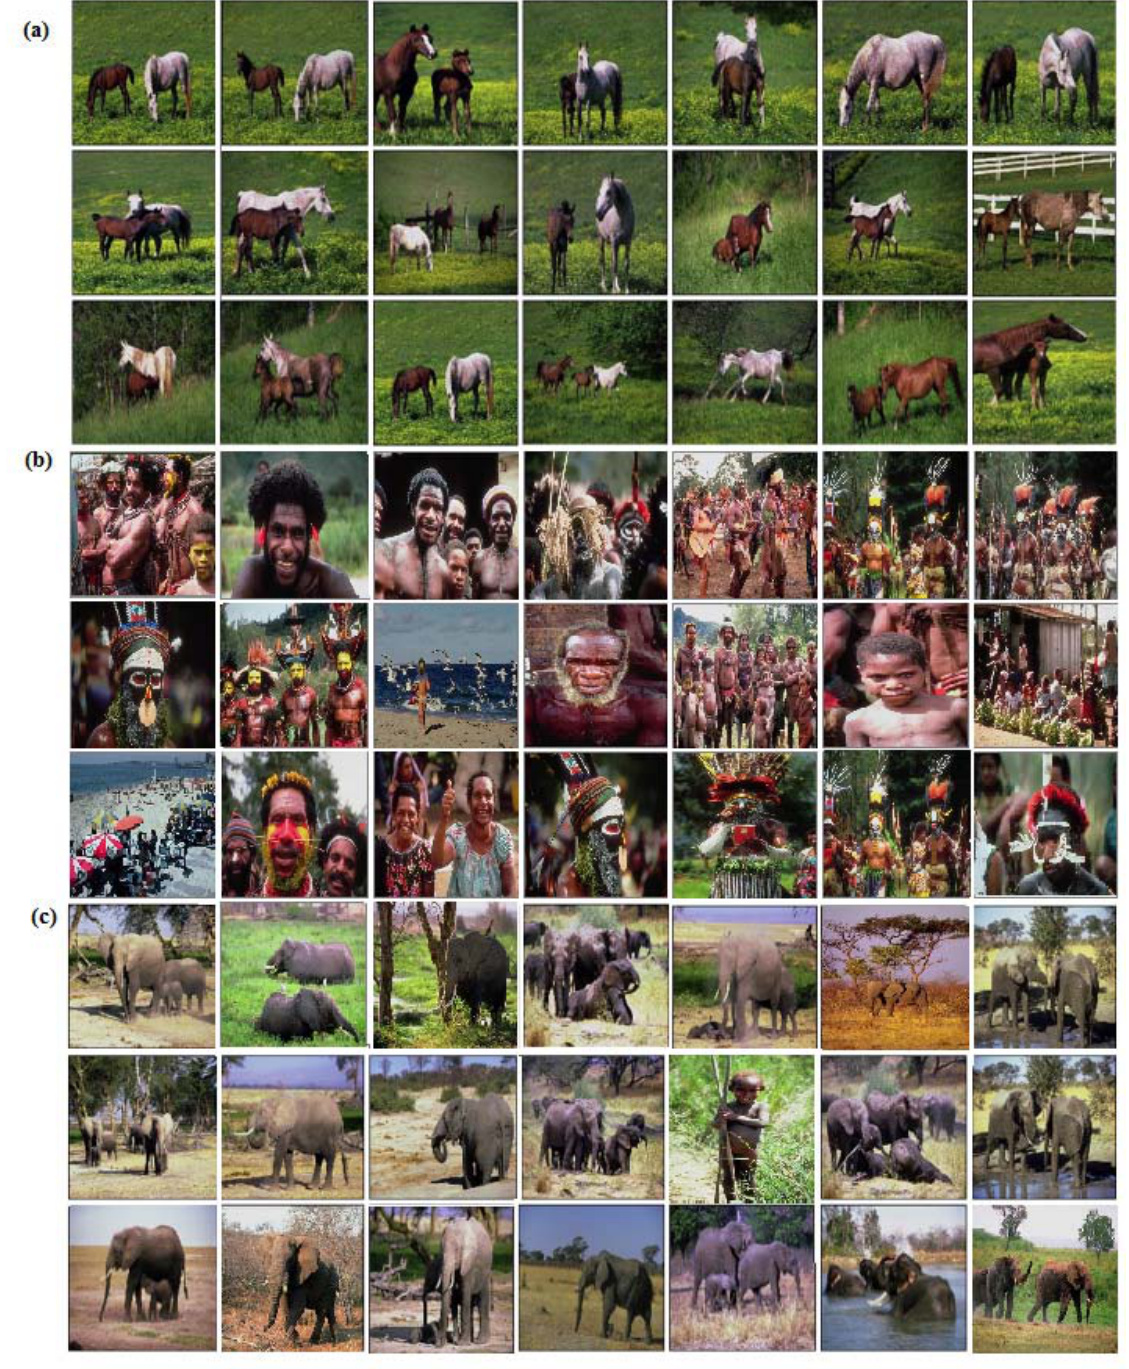
Fig. 8. Image retrieval results for class Horses, Africa, and Beach. 1st image in every group is the query image and all other images in that group are retrieved